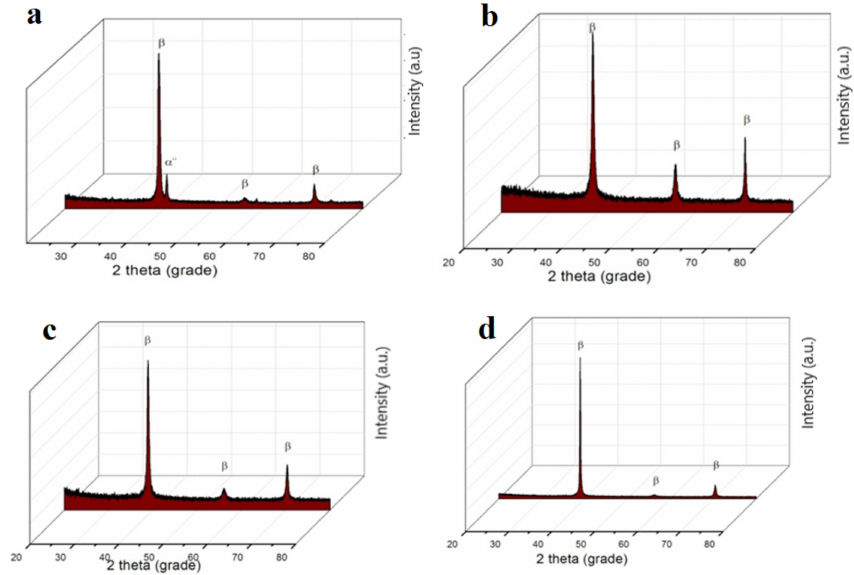
Figure 4. The XRD di ff raction patterns of titanium samples: ( a ) Ti 15 Mo 7 Zr 5 Ta, ( b ) Ti 15 Mo 7 Zr 15 Ta, ( c ) Ti 15 Mo 0.5 Si, and ( d ) Ti 15 Mo 1